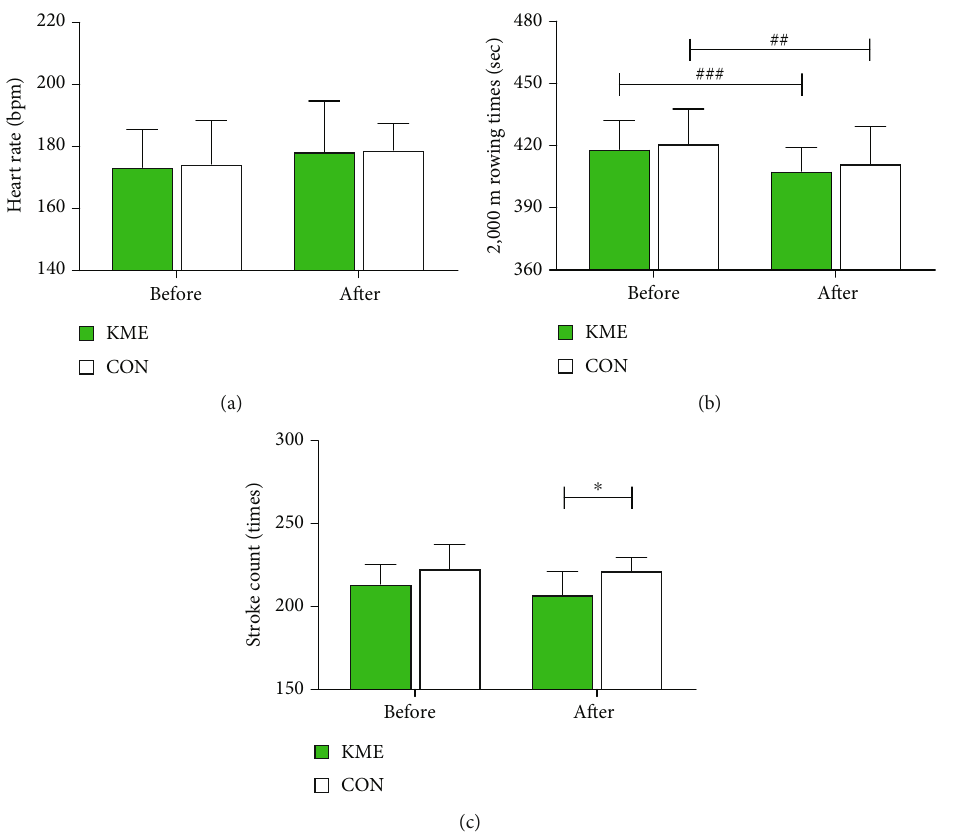
Figure 2: Before and after supplementation of 2,000 m rowing ergometer performance: (a) heart rate during the 2,000 m rowing test; (b) 2,000m rowing time trial; (c) total stroke count during the 2,000m rowing test. Data are shown as means ± SD . ## p < 0 : 01 and ### p < 0 : 001 before vs. after; ∗ p < 0 : 05 KME vs.